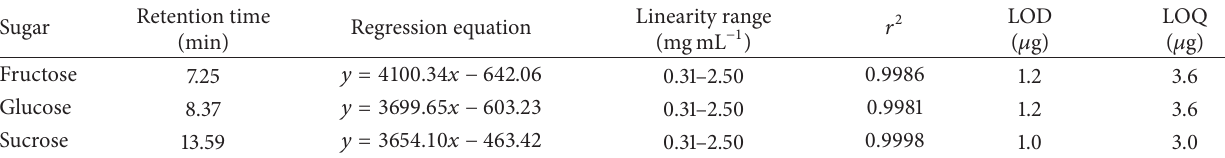
Table 2: Regression parameters and LOD and LOQ for fructose, glucose, and sucrose.